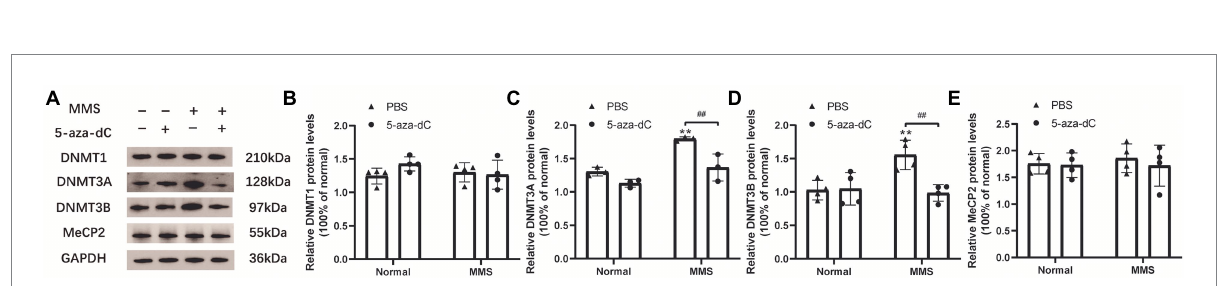
FIGURE 7 The interactive effect on protein levels of DNA methylation-related factors between MMS and 5-aza-dC. (A) Representative immunoblotting images of DNMT1/3A/3B, MeCP2 at 7 days after MMS treatment, GAPDH was used as an internal control. (B–E) Quantitative analysis of protein levels related to GAPDH. Data were expressed as mean ± SD, n = 3–4/group. ** p < 0.01 for differences compared to controls, ## p < 0.01 for differences between groups.